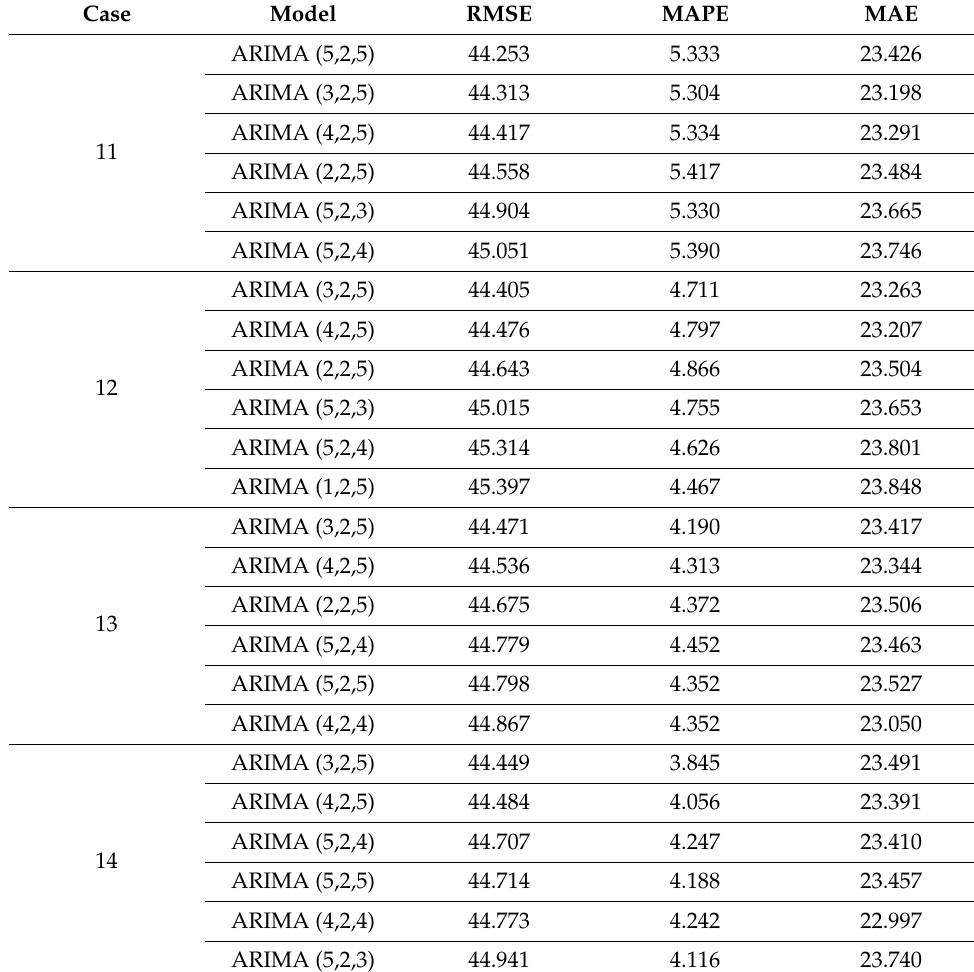
Table 6. Results of ARIMA models for Group 4 (case 11–14).